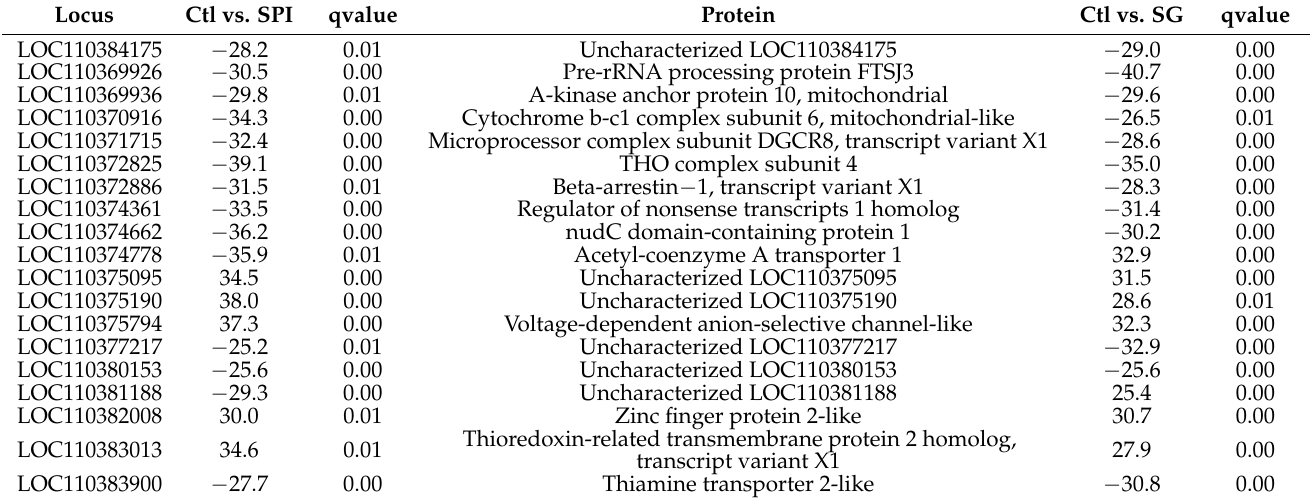
Table 2. Potential DNA methylation epialleles induced by SPIs in the genome of H. armigera . Locus Ctl vs. SPI Protein Ctl vs.